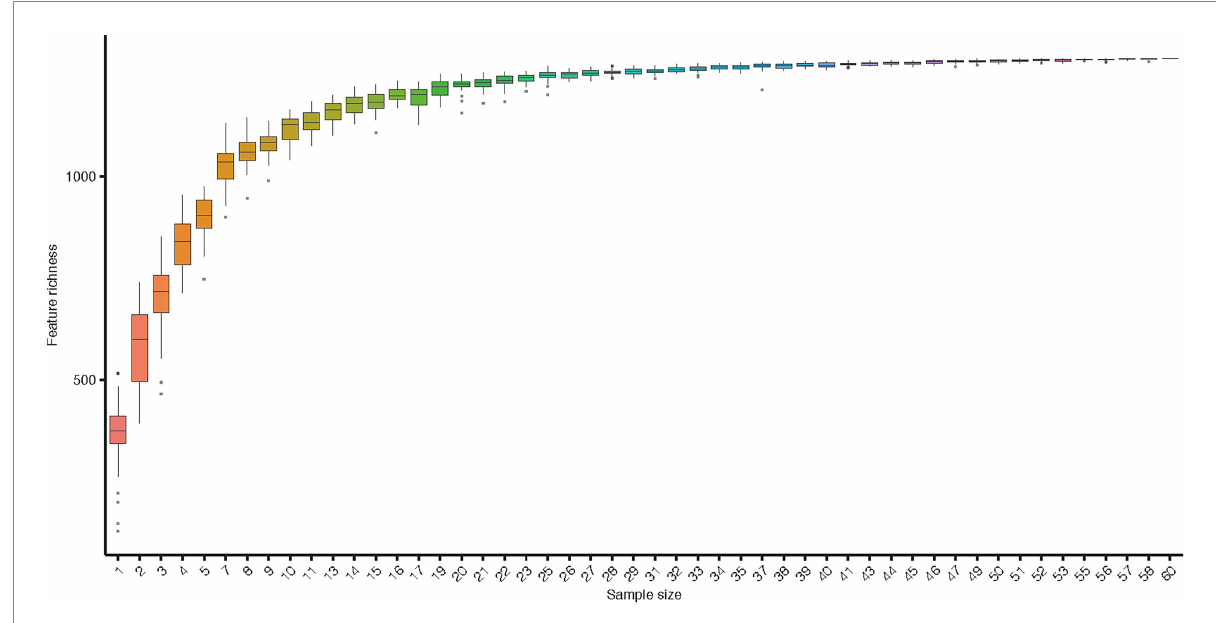
FIGURE 2 Rarefaction curve of gut microbiota. Accumulation curves for gut microbiota indices indicate that the sampling was comprehensive. Boxes denote the interquartile range (IQR) between the first and third quartiles (25th and 75th percentiles, respectively), and the line inside denotes the median. Whiskers denote the lowest and highest values within 1.5 times IQR from the first and third quartiles, respectively. Circles denote outliers beyond the whiskers.